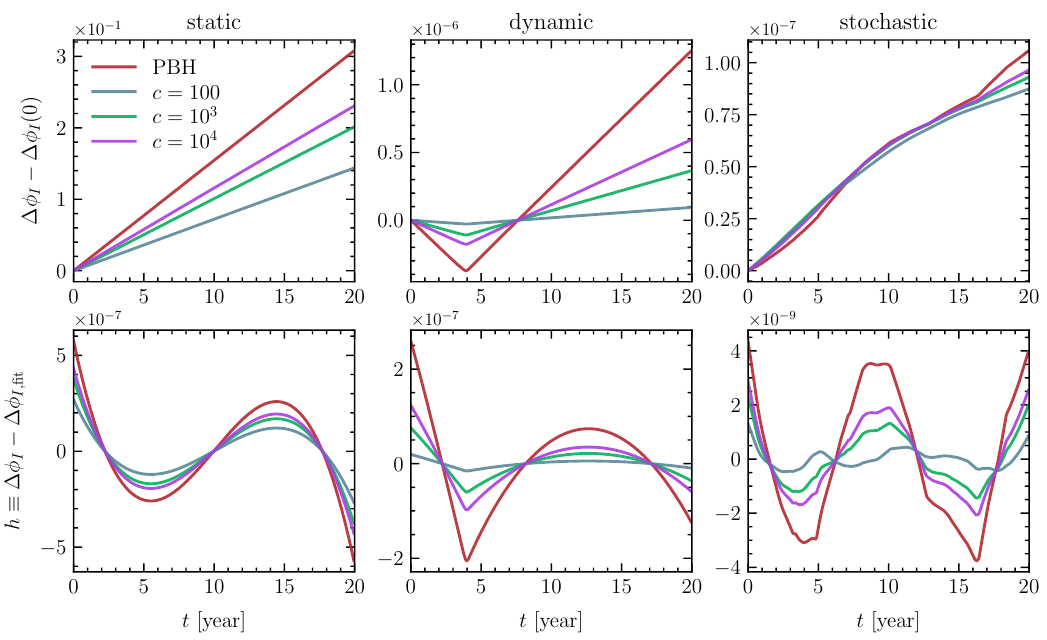
Figure 1 . Sample signal shapes of the static (left column), dynamic (middle column) and stochastic (right column) signals from DM subhalos with c = 100 , 10 3 , 10 4 and the Primordial Black Hole limit c → ∞ . The top row shows the unsubtracted signal shapes, computed from eqs. (2.8) and (2.9), while the bottom row shows the subtracted signal shapes after the terms degenerate with the timing model have been removed. The first two columns show the phase shift δφ ( t ) , eq. (2.8), from a single transiting subhalo and the last is the signal shape from multiple transiting subhalos, ∆ φ , in eq. (2.9). The signal shapes are taken from a realization of the Monte Carlo. The mass of the subhalos are 10 − 2 M , 10 − 11 M and 10 − 14 M for the static, dynamic and stochastic signals respectively. (cid:12) (cid:12) (cid:12) Only the closest subhalo is kept for the static and dynamic signals, while all subhalos are kept for the stochastic